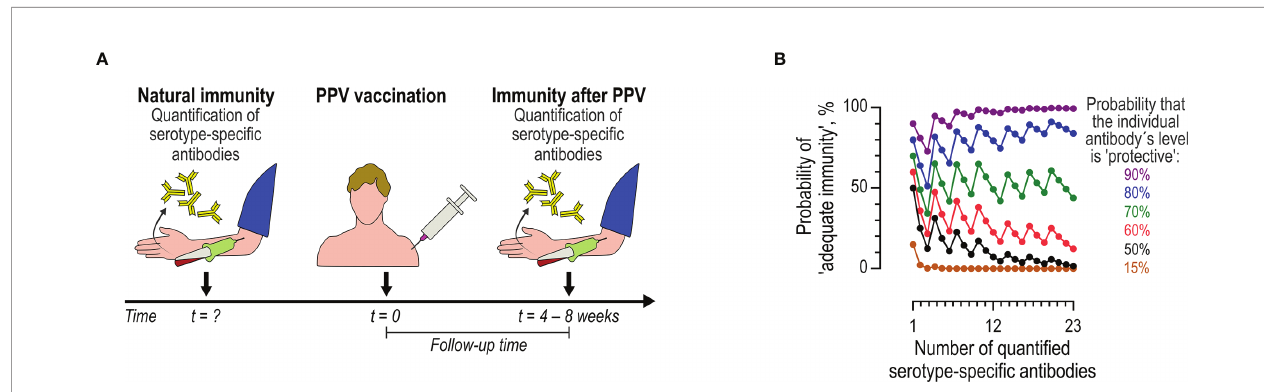
FIGURE 1 | Diagnostic vaccination according to the AAAAI guidelines. (A) Flow of events. The preexisting immunity (natural immunity), represented by the levels of multiple (unde fi ned number) serotype-speci fi c antibodies, is determined at an unde fi ned time-point before vaccination (t = ?). Later, PPV is administered (t = 0). The immunity after PPV is assayed four to eight weeks later by quantifying the same serotype-speci fi c antibodies. (B) Model showing the theoretical probability of achieving adequate immunity (y-axis, left) according to the AAAAI guidelines (i.e., the probability of at least 70% of serotype-speci fi c antibodies reaching levels of at least 1.3 mg/L) as a function of the number (x-axis) of tested serotype-speci fi c antibodies. The colored curves represent different probabilities of an individual antibody being classi fi ed as ‘ protective ’ (i.e., a level of at least 1.3 mg/L). The probability of achieving ‘ adequate immunity ’ follows the binomial distribution, under the simplifying assumption that the individual serotype-speci fi c antibodies in a given panel have equal likelihoods of being at the ‘ protective ’ level (although this will rarely be the case, the simpli fi cation nonetheless serves to illustrate the underlying